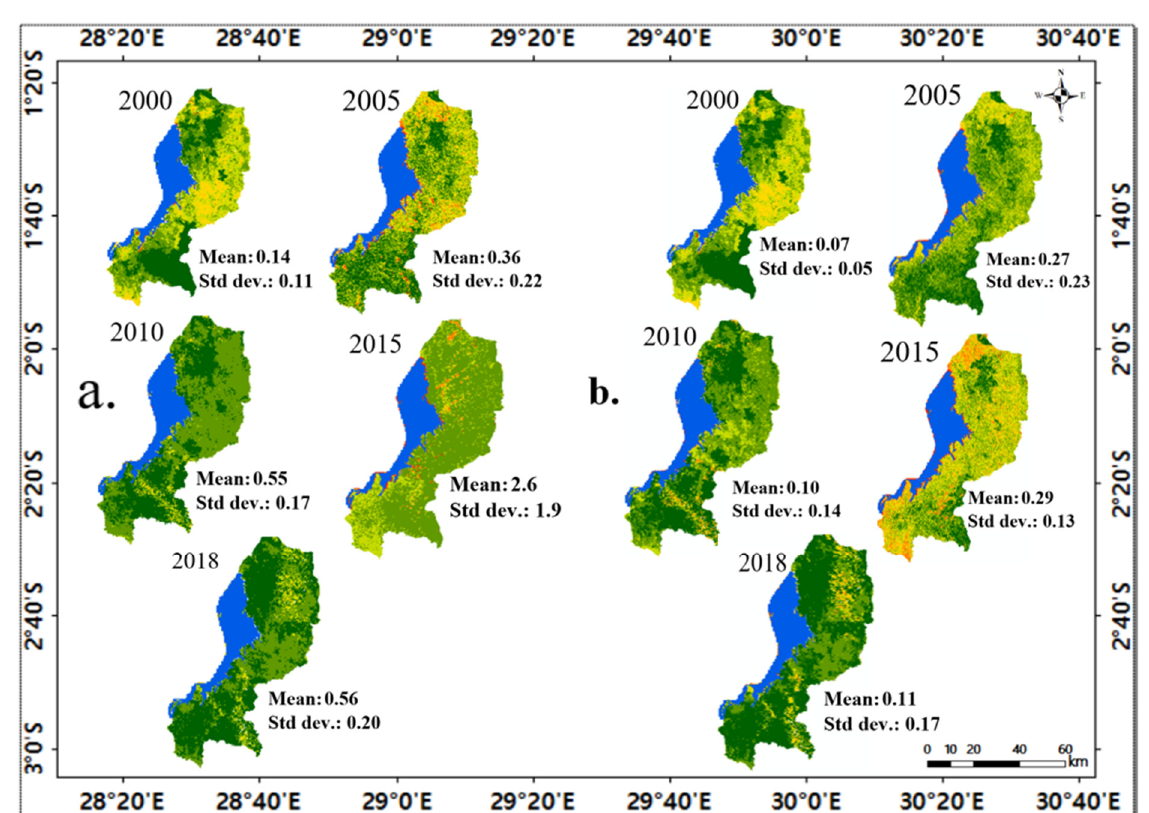
Figure 4. Comparison between the RUSLE cover management (C) factor maps: ( a ) using the formerly used approach (Cvk);and ( b ) using the adapted approach (CvkA) for the considered years.